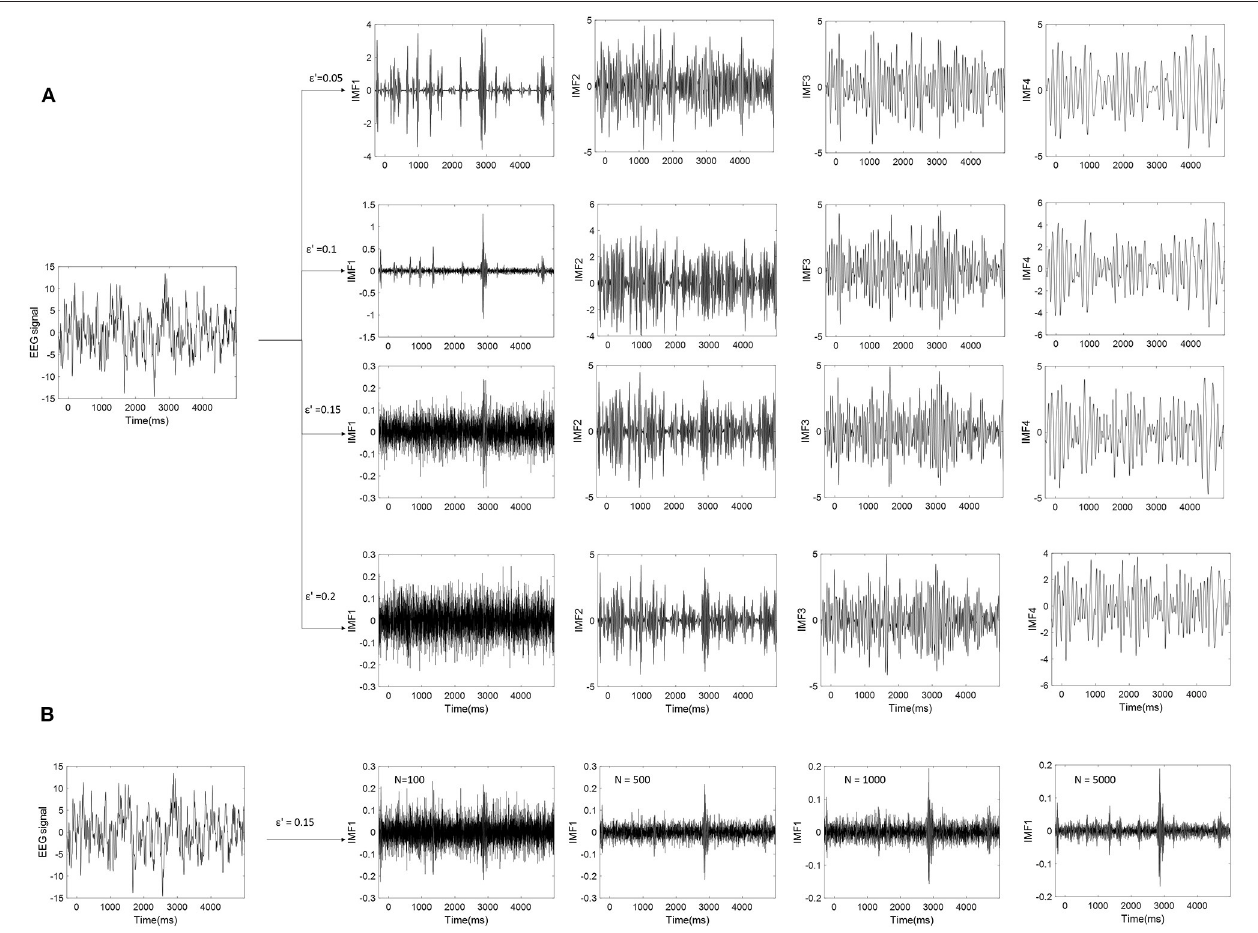
FIGURE 6 | (A) The EEMD decomposition of EEG signal by adding different Gaussian noise. (B) The effect of noise on the first IMF (IMF1) are reduced by increasing the number (N) of ensemble members ( ε ′ is set to 0.15).